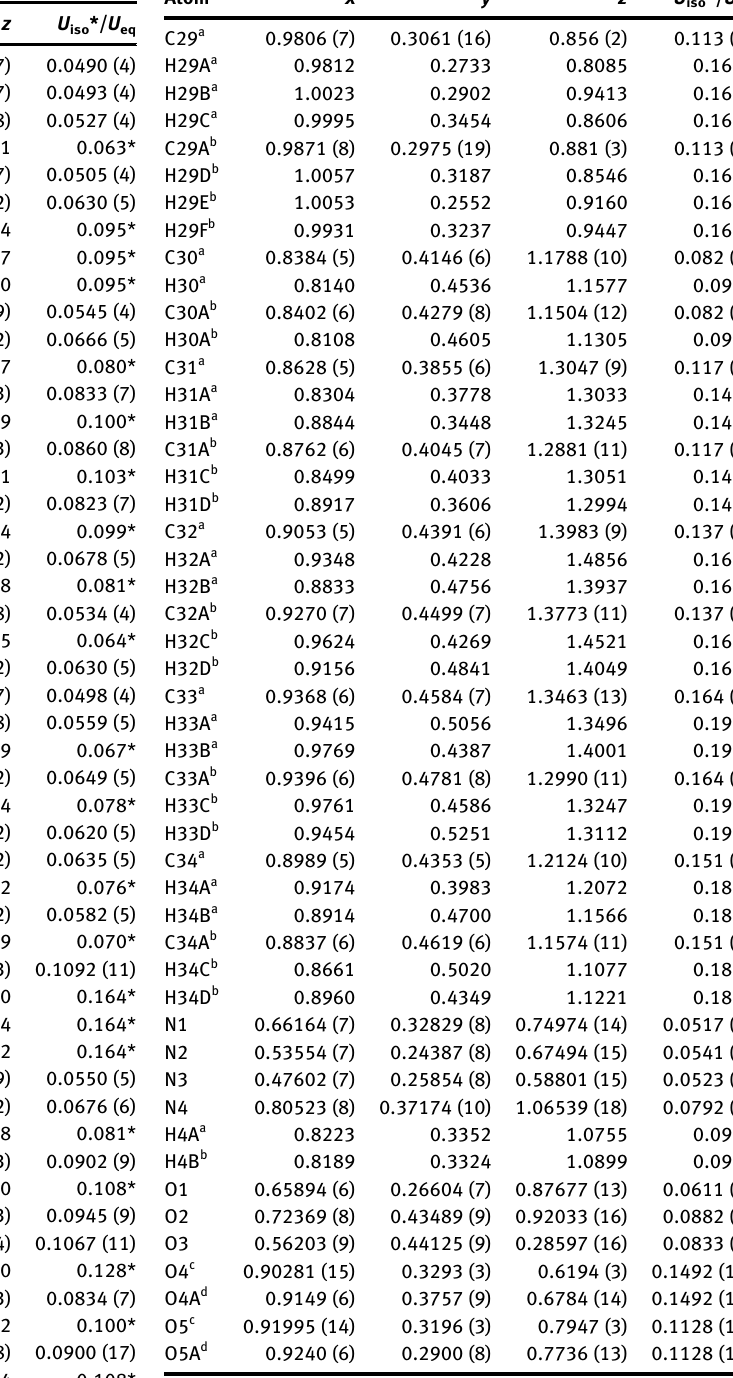
Table  : Fractional atomic coordinates and isotropic or equivalent isotropic displacement parameters (Å 